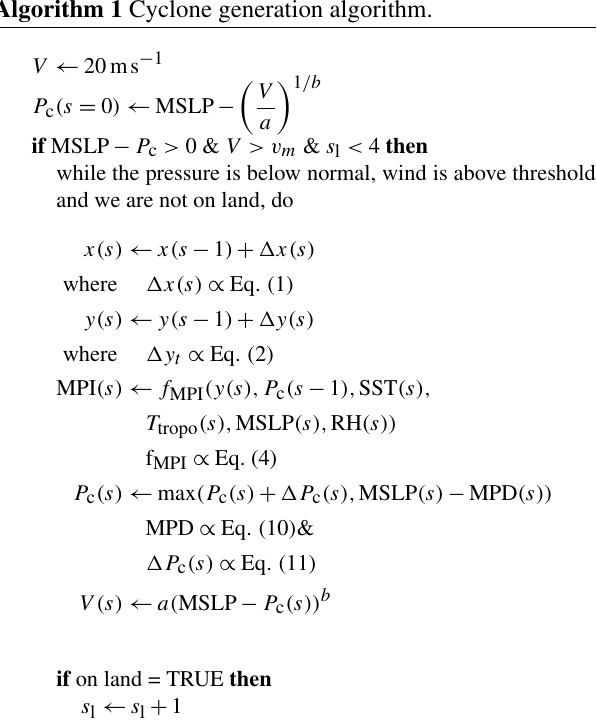
Algorithm 1 Cyclone generation algorithm.